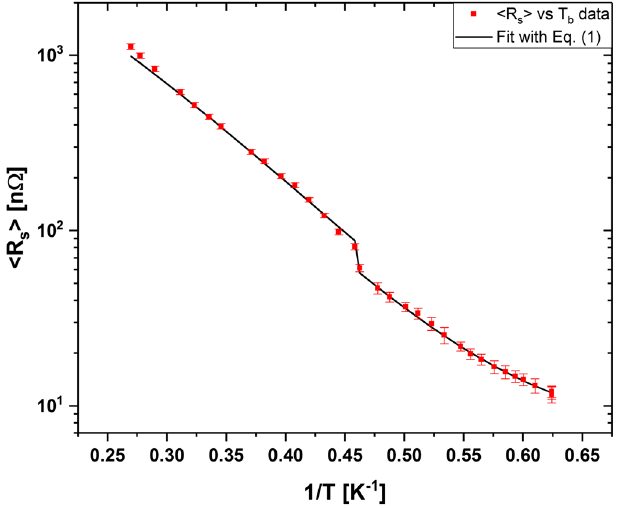
FIG. 5. FH3A data between T b ¼ 3 . 7 K and T b ¼ 1 . 6 K at ∼ 4 . 2 MV = m. The solid black line was obtained from a least- E acc squares fit with Eq. (1).